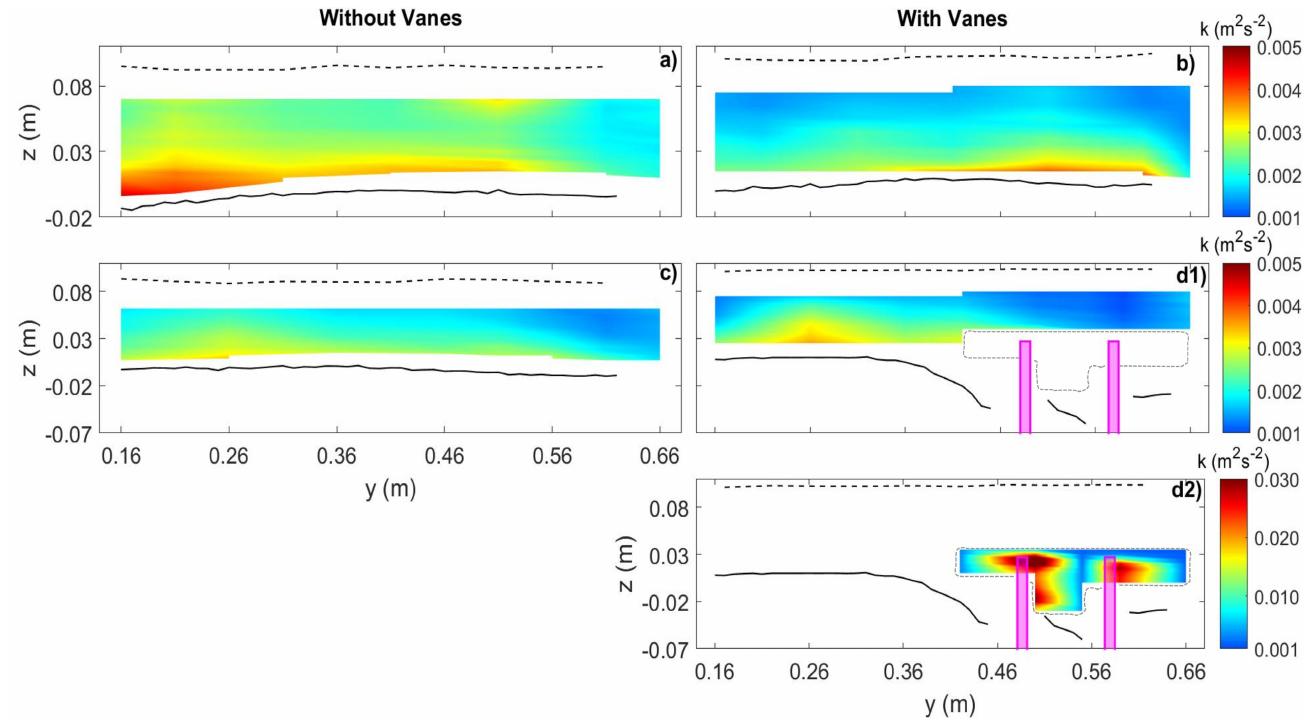
Figure 17. Turbulent kinetic energy k (m 2 · s − 2 ) as color scale, in the NV and the VF experiments, in the main channel upstream of the diversion, at cross-sections: ( a ) x = − 1.00 m. ( b ) x = − 1.00 m. ( c ) x = − 0.30 m. ( d1 ) x = − 0.36 m. ( d2 ) x = − 0.36